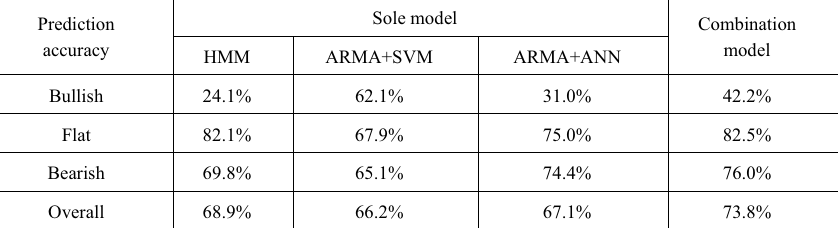
Table 5. The basic results of